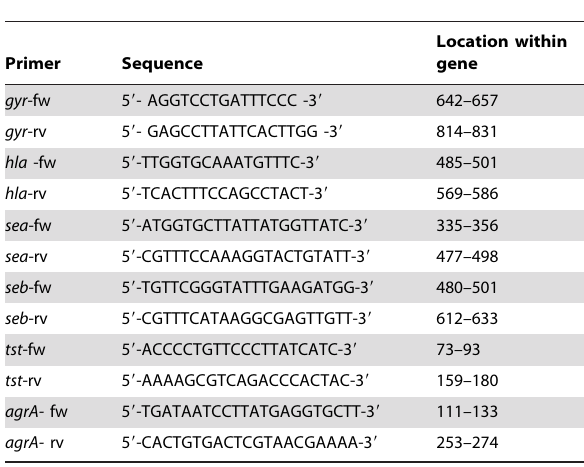
Table 4. Primers used for real-time